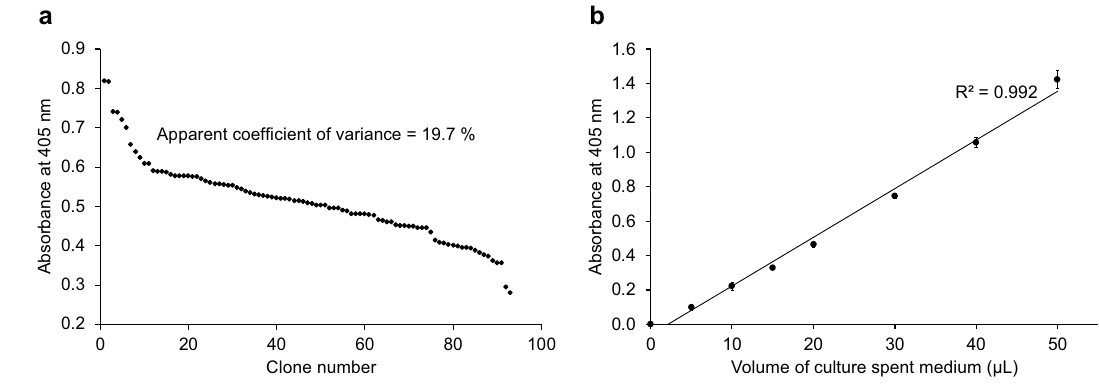
Figure 1. The OsmY(WT)-Tfu0937 activity in the spent medium was measured with the pNPG assay using an absorbance at 405 nm. ( a ) The pNPG assay was performed in a 96-well microplate for OsmY(WT)-Tfu0937- expressing C41(DE3) cells cultivated in a 96-well deep well plates. The coefficient of variance was calculated using the absolute values measured at 405 nm. ( b ) The pNPG assay was conducted using 5–50 µL of spent medium. The activity value is linear to the volume of spent medium used with an R 2 = 0.992.